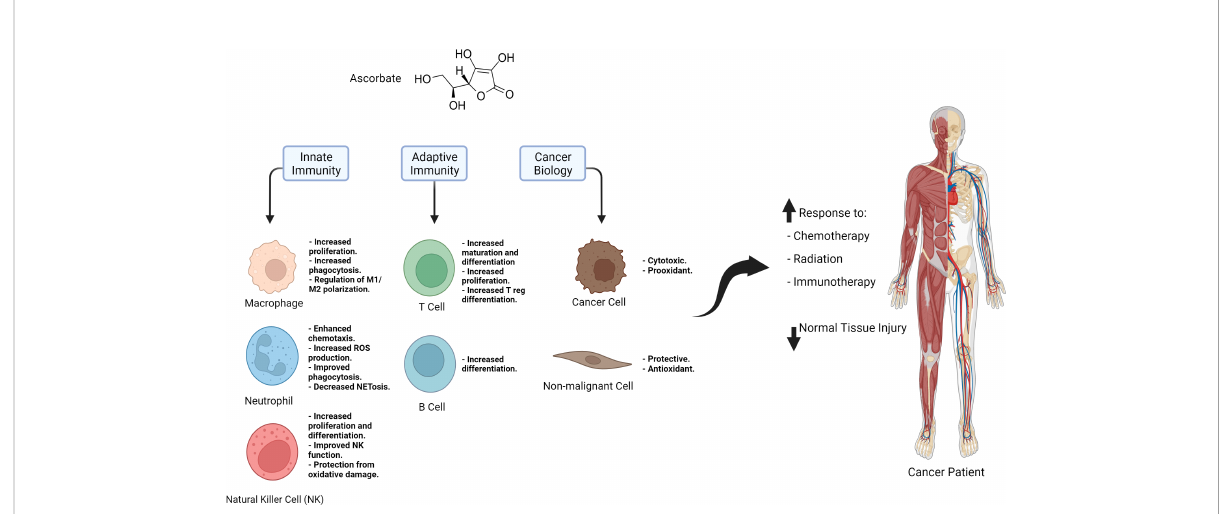
FIGURE 1 Summary of the immune regulatory effects of ascorbate, the role it plays it cancer and non-malignant cells, and its potential applications in cancer